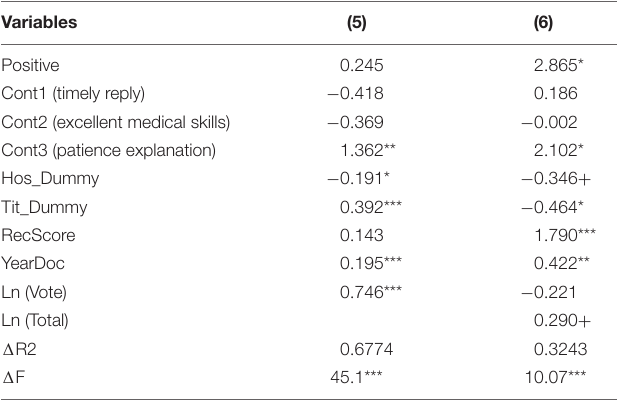
TABLE 10 | Robustness